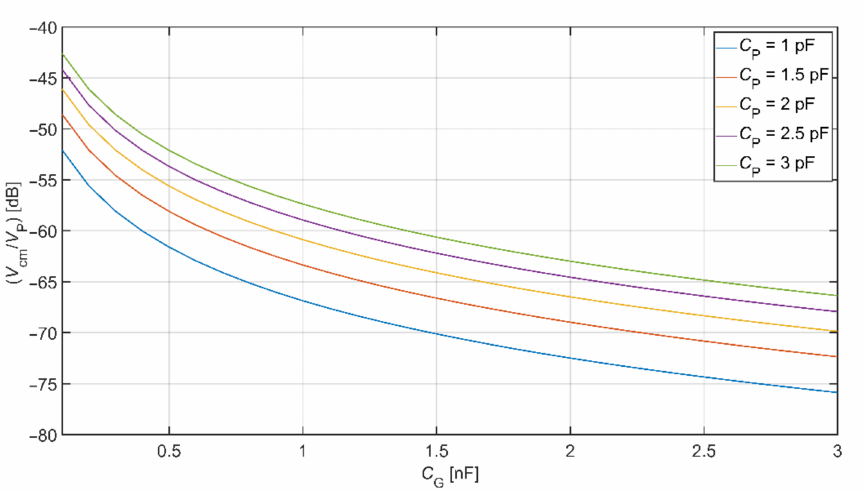
Figure 7. Common-mode voltage rejection for a system with noise suppression electrode (NSE) electrode connected to the system